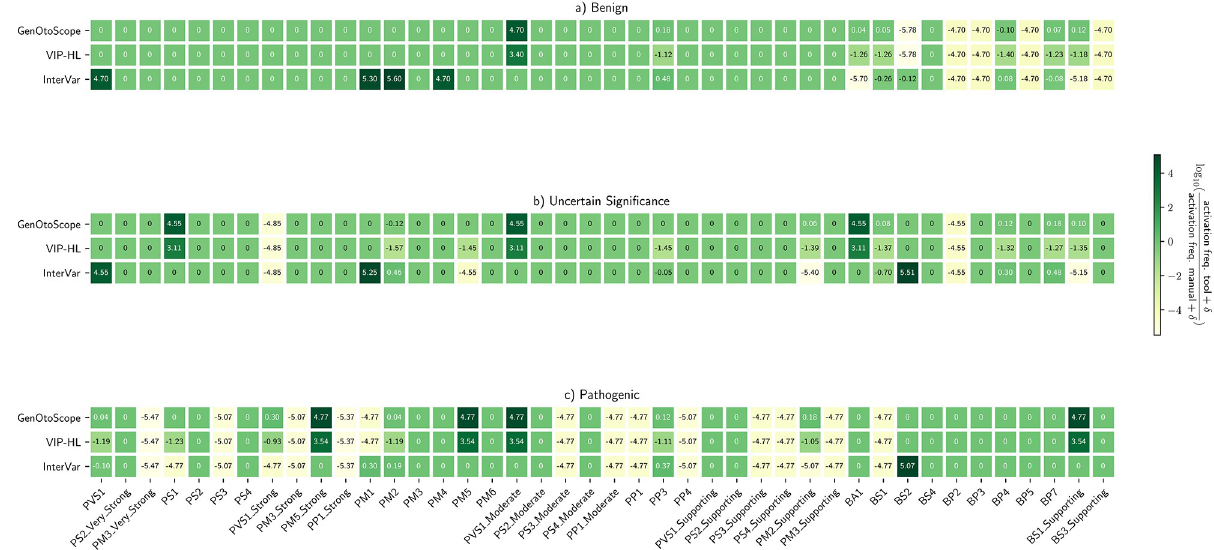
Fig 12. Activation frequency ratios for MHH data set. Log ratios calculated for each of the three classes classified by the MHH manual curators: (A) “Benign” broader class, (B) “VUS” class and (C) “Pathogenic” broader class.